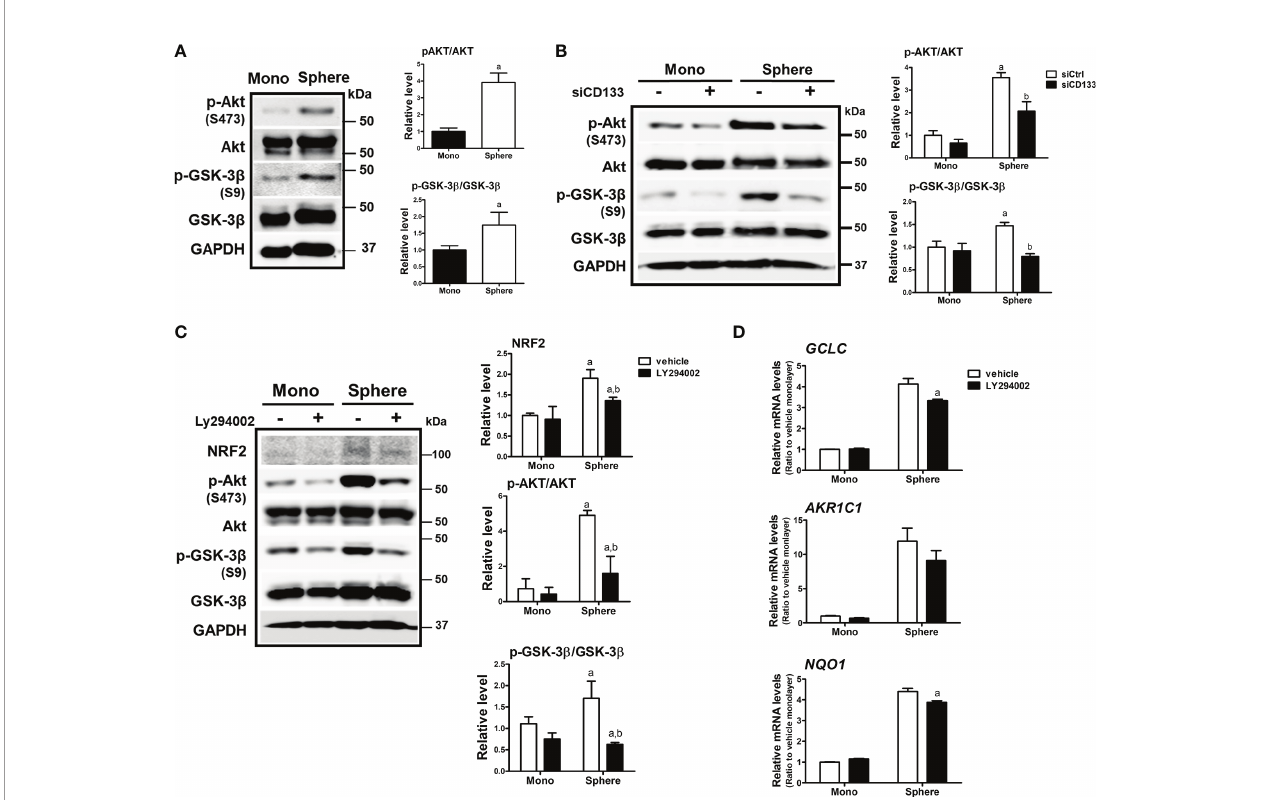
FIGURE 3 | Involvement of PI3K/AKT/GSK-3 b signaling in NRF2 activation in HCT116 spheres. (A) Protein levels of p-AKT (S473), total AKT, p-GSK-3 b (S9), and total GSK-3 b were determined in monolayer and sphere HCT116 cells. Bar graph represents quanti fi ed protein levels from at least three experiments. a P < 0.05 compared with the monolayer group. (B) HCT116 cells were transfected with the non-speci fi c siRNA (siCtrl) or CD133-speci fi c siRNA (siCD133) and grown in either monolayer or sphere culture system. Protein levels for p-AKT (S473), AKT, p-GSK-3 b (S9), and GSK-3 b were assessed using western blotting. Bar graph represents quanti fi ed protein levels from at least three experiments. a P < 0.05 compared with the monolayer group. (C) LY294002 (10 m M), a pharmacological inhibitor of PI3K, was incubated in monolayer and sphere HCT116 cells for 24 h, and protein levels of NRF2, p-AKT (S473), AKT, p-GSK-3 b (S9), and GSK-3 b were determined. Bar graph represents quanti fi ed protein levels from at least three experiments. a P < 0.05 compared with the monolayer vehicle group. b P < 0.05 compared with the sphere vehicle group. (D) Transcript levels of GCLC AKR1C1 , and NQO1 were measured using a relative qRT-PCR analysis in vehicle- or LY294002-treated cells. a P < 0.05 compared with the vehicle-treated sphere group. Quanti fi cation results of western blotting were relative values to the loading control GAPDH. Values represent the mean ± SEM of more than three